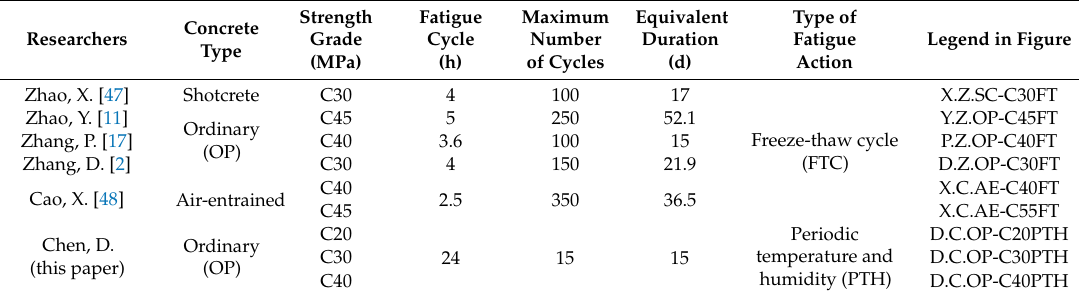
Table 5. Basic information of relevant research.